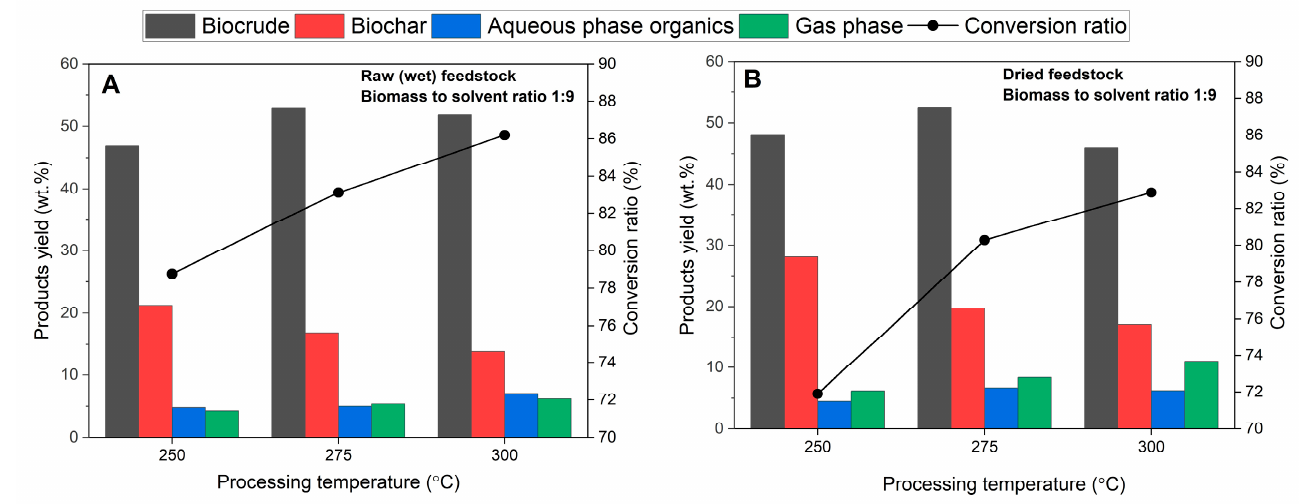
Figure 1. Effect of solvothermal liquefaction processing temperature on yields distribution of resultant bioproducts and conversion ratio tested for: ( A ) raw (wet) feedstock, ( B ) pre-dried feedstock.